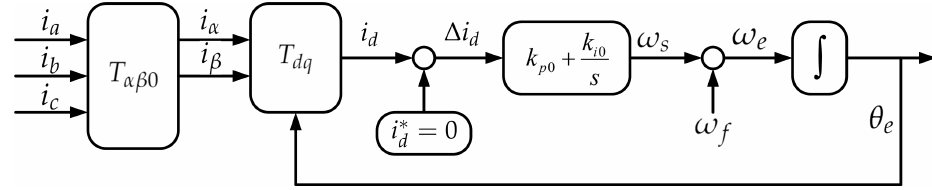
Figure 3. PLL block